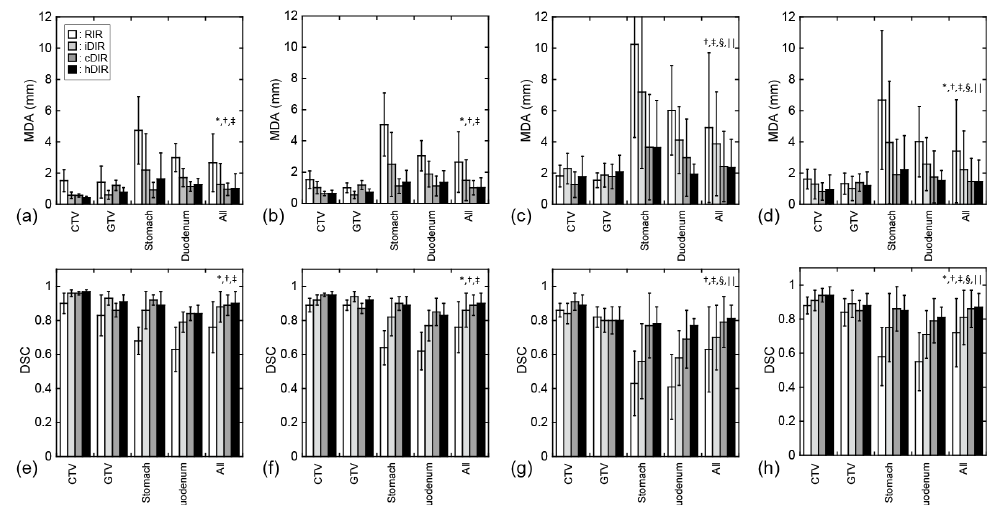
Figure 3. Registration errors using contours. All graphs show mean ± standard deviation. White, light-gray, dark-gray, and black bars show rigid image registration (RIR), iDIR, cDIR, and hybrid iDIR-cDIR (hDIR), respectively. ( a – d ) show the MDA for each contour, and ( e – h ) show the dice similarity coe ffi cient (DSC) for each contour. ( a , e ) SP-SP cases. ( b , f ) SP-PR cases. ( c , g ) SP-PR cases. ( d , h ) all cases. *, † , ‡ , §, and || indicate significant di ff erences between RIR and iDIR, RIR and cDIR, RIR and hDIR, iDIR and cDIR, and iDIR and hDIR, respectively. Table 1. Absolute differences in the dose-volume parameters. All data show the median (range).